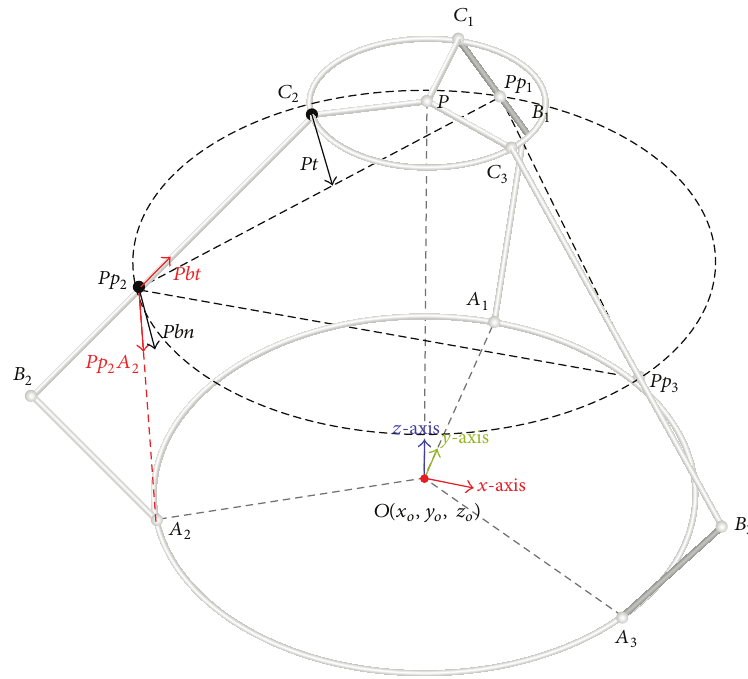
Figure 6: Cabri 3D geometric model of micromanipulator with vectors indicates angular translation 𝛿